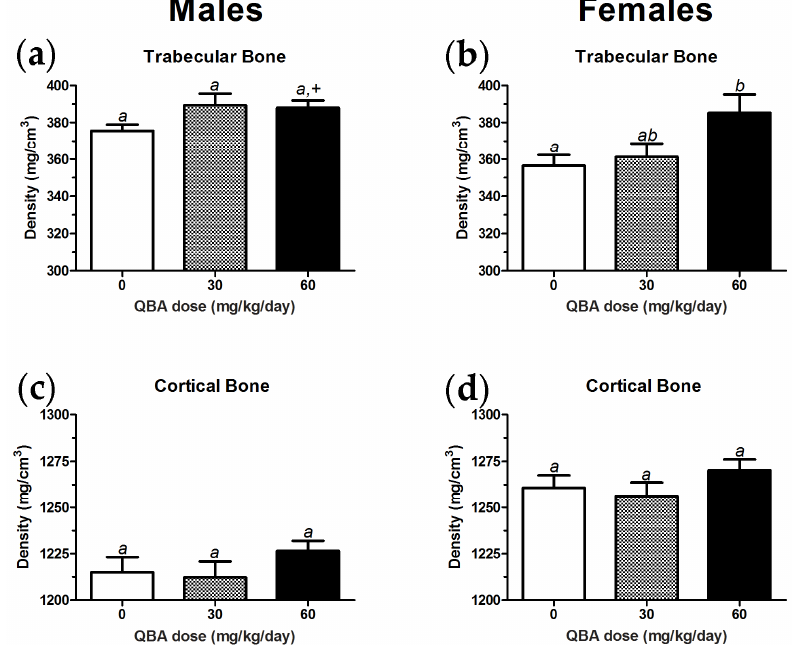
Figure 6. QBA increased trabecular bone density in female mice. ( a ) A non ‐ significant trend